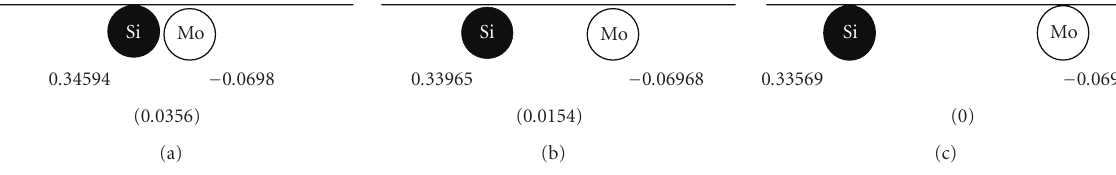
Figure 5: Chemical and total (in parenthesis) energy contributions (in eV) of an Al/U interface with a Si (black disk) and an Mo atom in the top fuel layer, for di ff erent separations: (a) as nearest-neighbors, (b) as next-nearest-neighbors, and (c) far from each